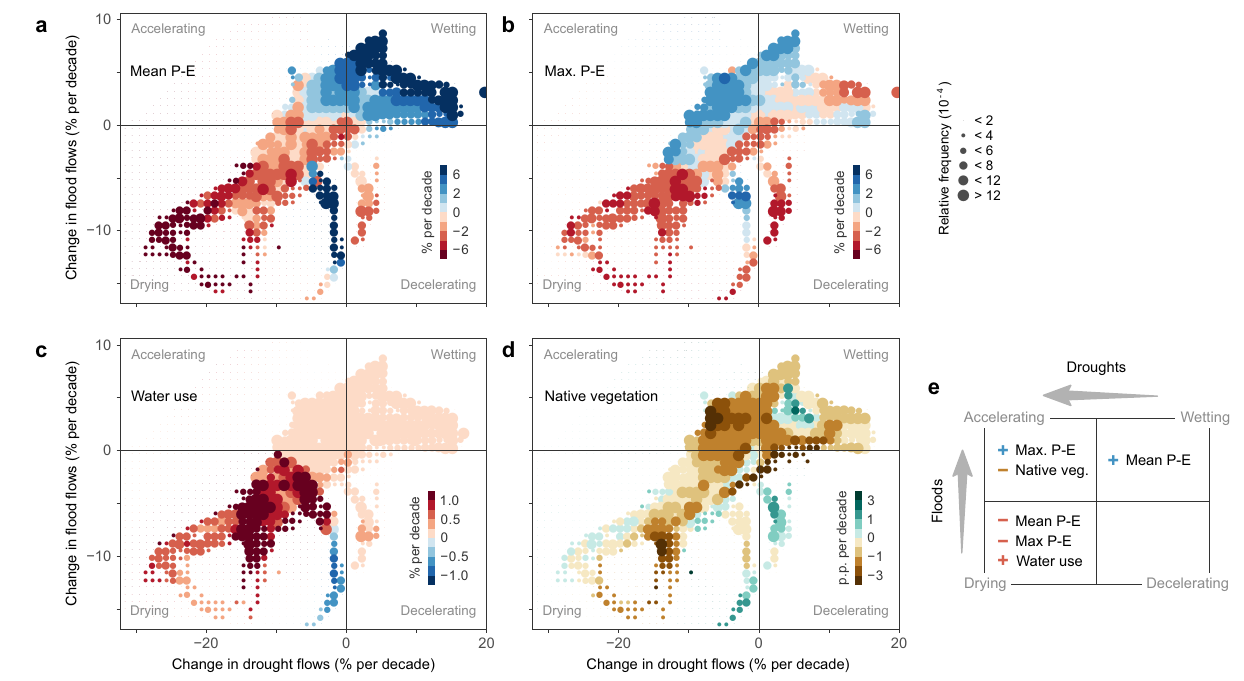
Fig. 4 | Trends of the drivers mapped on the quadrants of the accelerating, decelerating, wetting, and drying stream fl ow trends of Fig. 3b. a Mean daily precipitation minus evaporation (P – E). b Maximum annual 14-day P – E. c Water use in % of the long-term mean daily fl ow per decade. d Native vegetation cover in